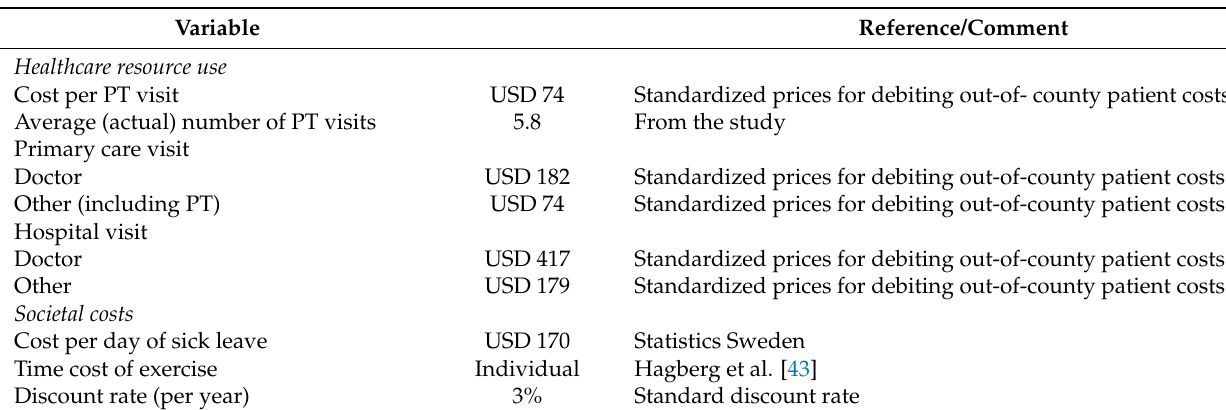
Table 2. Input data for cost